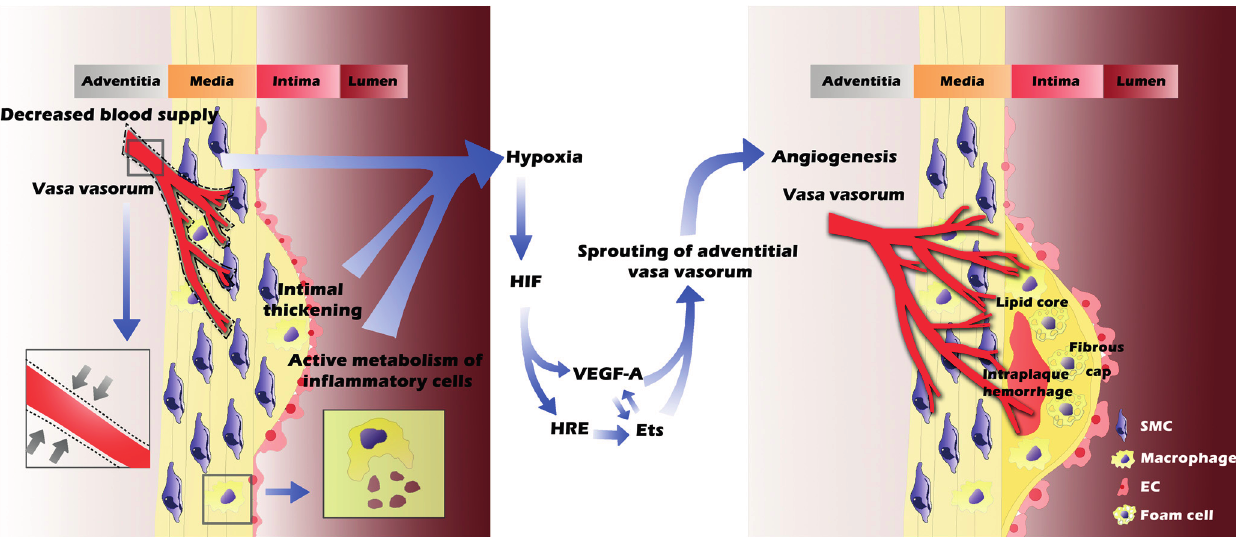
Figure 2. Intimal thickening, decreased blood supply (due to high pressure in parent vessel and the stimulated constriction of VV, represented by grey arrows in the left closed box) and active metabolism of inflammatory cells together contribute to hypoxia in atherosclerotic vessels ( left panel). The oxygen-insufficient microenvironment in inner layers of vessel wall further induces angiogenesis through activating HIF, VEGF-A and Ets signaling pathways. As a result, the formation of intraplaque neovessels originating from VV leads to the progression of atherosclerotic plaques, including intraplaque hemorrhage, lipid core enlargement, inflammatory cell infiltration, and ultimate rupture ( right